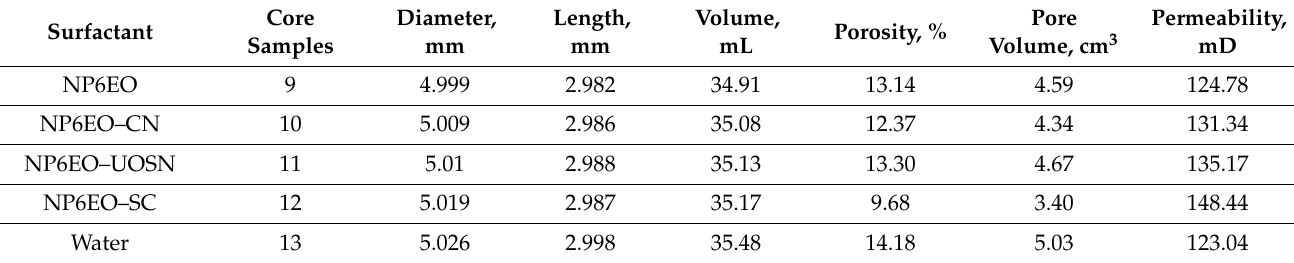
Table A2. Core for spontaneous imbibition